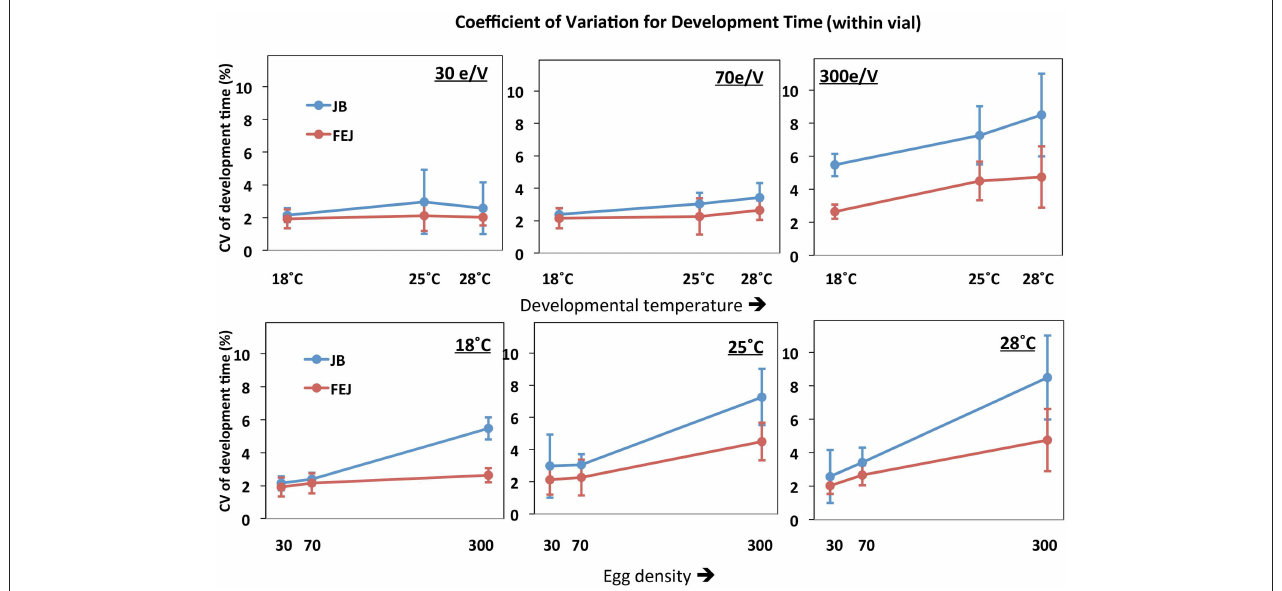
FIGURE 3 | Coefficient of variation (CV) of pre-adult development time of FEJ and JB populations across individuals within a vial. The upper panel shows CV of the trait plotted across temperature for each treatment density (e/V = eggs per vial). The lower panel shows CV of the trait plotted across egg density for each treatment temperature. The error bars show 95% confidence intervals calculated from the variation among replicate populations in each combination of selection regime, temperature, and density.